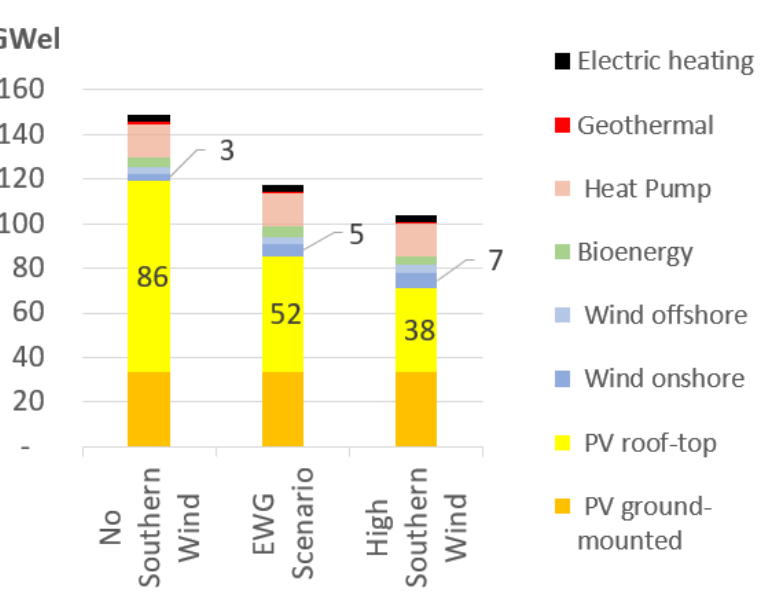
Figure 9. Required average annual additions (in GW) for 100% RE in 2030 in